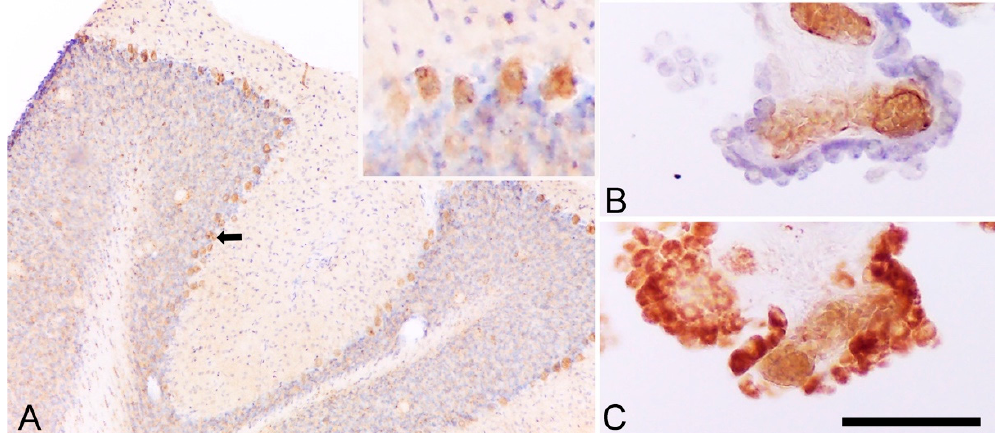
Figure 3. TSPO is expressed by Purkinje and choroid plexus cells. ( A ) The immunoreactivity of rat cerebellum to TSPO (with cresyl violet counterstaining) underlines a positive staining in Purkinje cells (the black arrow indicates an example and insert), as demonstrated in mouse cerebellum [102]. ( B ) Immunoreactivity of human choroid plexus cells to CD31 (endothelial cells) with cresyl violet counterstaining (epithelial cells). ( C ) Immunoreactivity of human choroid plexus cells to TSPO underline both epithelial and endothelial cells positive for TSPO (as previously published in Reference [101]). Scale bar: 250 μ m.